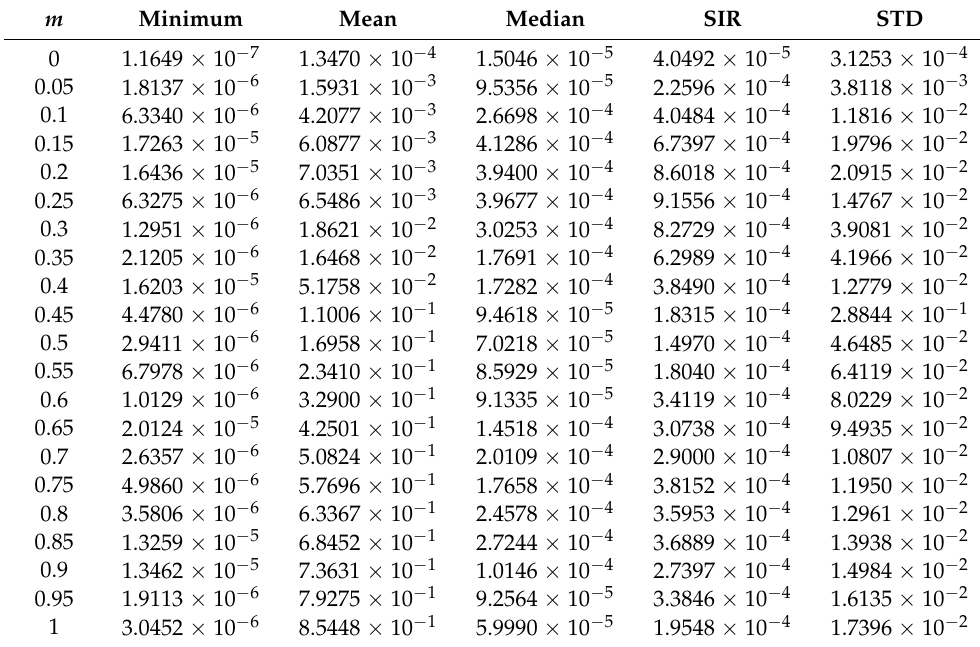
Table 2. Statistical measures for the stochastic operators based on case 2 for the